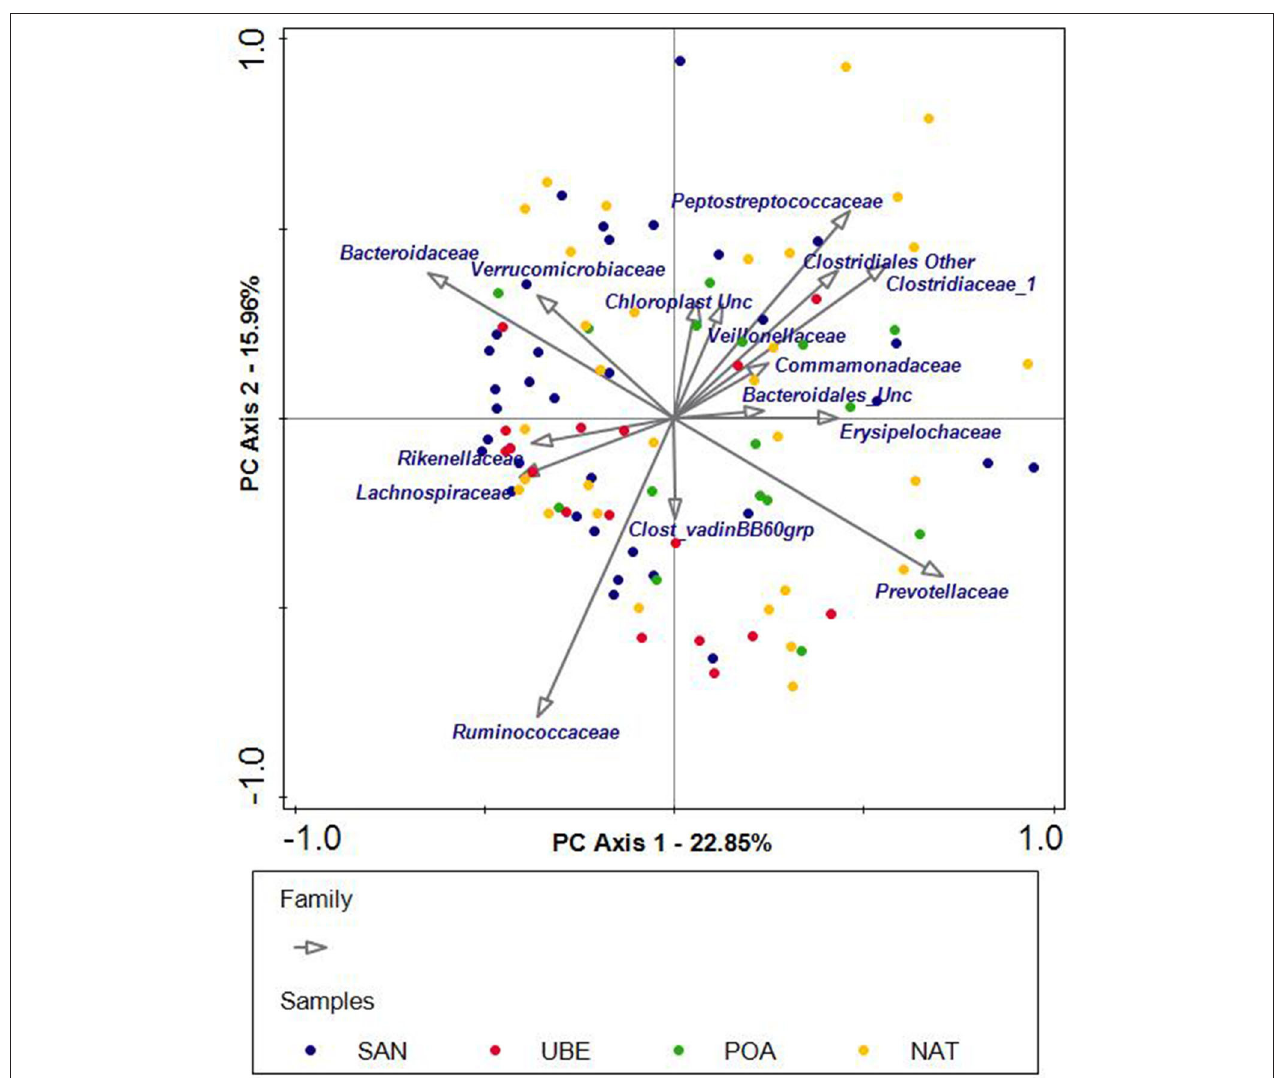
FIGURE 5 | Unconstrained principal component analysis (PCA) of subjects grouped into four geographical regions: San Andre (SAN), Uberaba (UBE), Porto Alegre (POA), and Natal (NAT). Each dot represents one sample, and each color corresponds to a region. The PCA plot shows scattering of the samples across the quadrants. The arrows indicate the bacterial genera or families that potentially influence the scattering of the